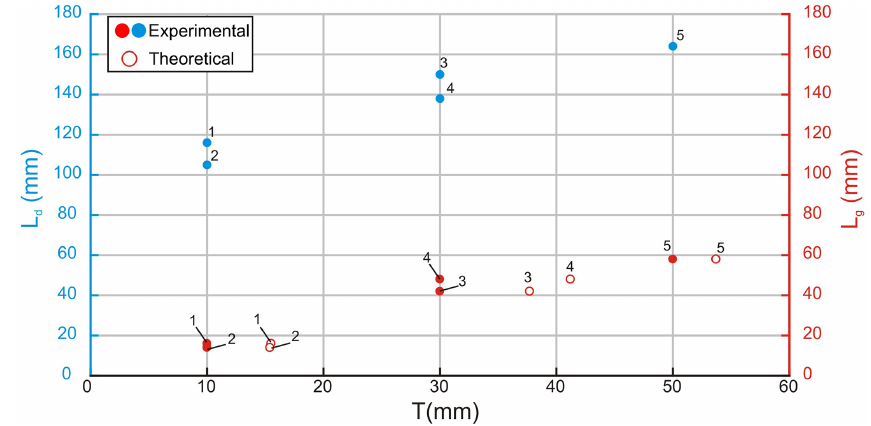
Figure 8. L g (apical depression width) and L d (dome diameter) versus T (overburden thickness). Theoretical values calculated after Eq. (1) (see the Discussion section). The numbers above each point indicate the experiment number.